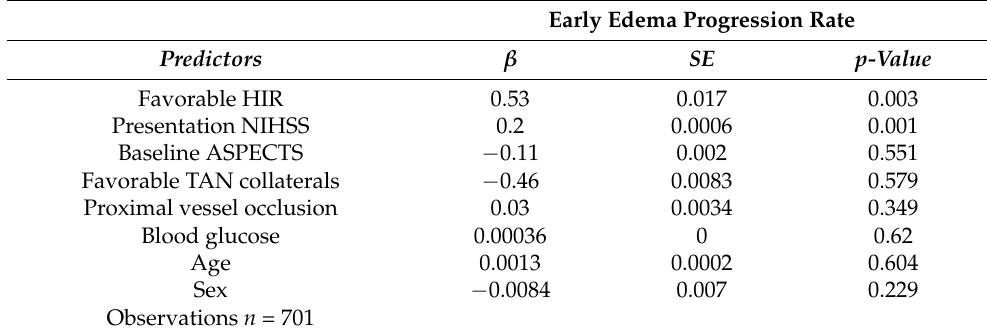
and frequencies, mean ± SD or median and interquartile range (IQR). Univariate logistic regression analysis between HIR+ and HIR − for all parameters is displayed on the very right column with corresponding p -values.